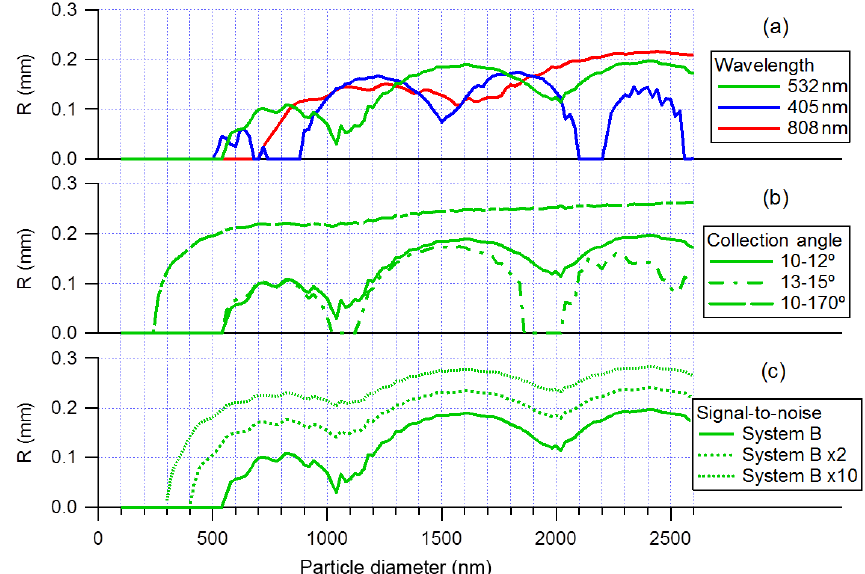
Figure 8. Results of modelling the optical detection geometry with selected design configurations, showing the calculated effective detection radius ( R ) with respect to particle diameter for PSL particles (refractive index = 1.59). Profiles are modelled by changing only one parameter with respect to the design of detection system B, which is shown as a solid green line in each plot for reference. The reference configuration of detection system B is σ d = 0 . 0825mm, wavelength = 532nm, and a light collection angle of 10–12 ◦ . (a) The effect of using detection laser wavelengths 405 and 808nm, (b) the effect of light collection angle of 13–15 and 10–170 ◦ , (c) the effect of improving the signal-to-noise ratio of detection system B twofold ( × 2) and 10-fold ( ×